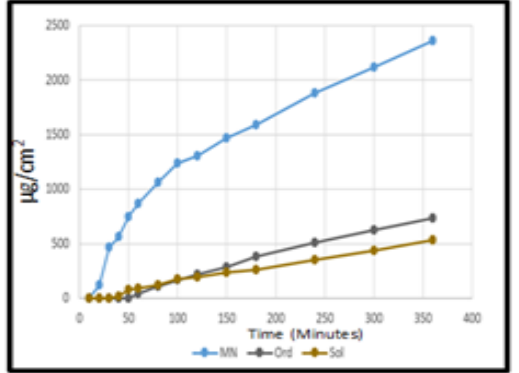
Figure 5. Collective Ex vivo permeation study of MN F10+3%T80, ordinary patch F10+3%T80 and LXM solution in phosphate buffer pH 7.4 and at a temperature of 35± 0.50